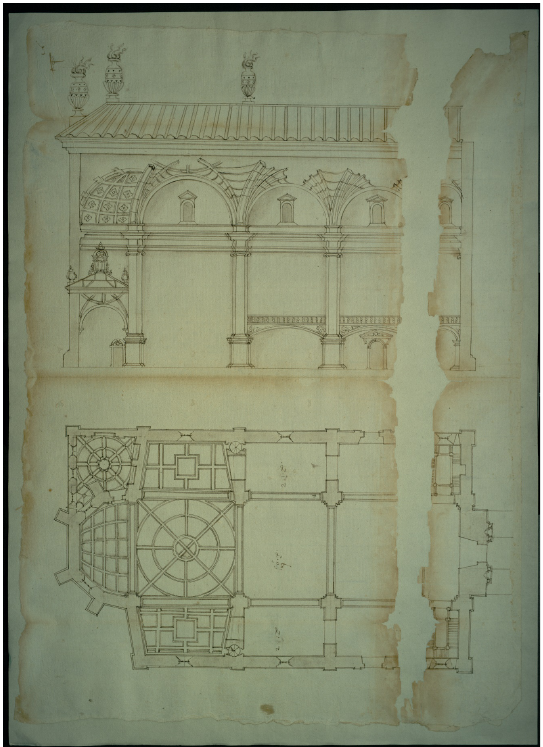
Figure 13. Project for the parish church of Nuestra Señora de la Asunción in Zumárraga (Guipúzcoa) [Archivo Diocesano de Pamplona (A.D.P.), Procesos, Secr. Ibarrola, c/70 – nº 27]. © Archivo Diocesano de Pamplona.